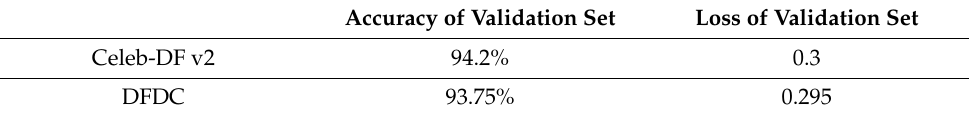
Table 2. Training results of the classifier network on validation set of Celeb-DF v2 and DFDC.